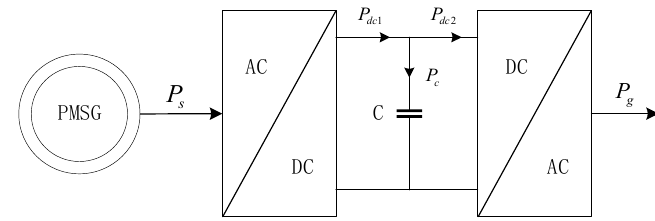
Figure 4. Schematic diagram of power flow.